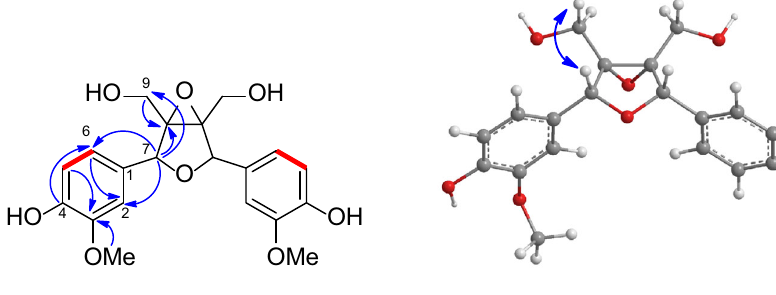
Fig. 4 Key HMBC ( blue arrows H ? C), 1 H- 1 H COSY ( red lines ), and ROESY correlations ( blue double- headed arrow ) of 2